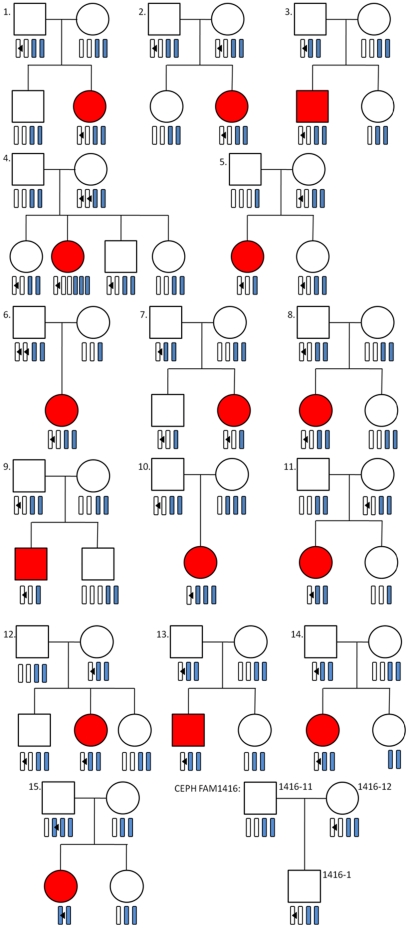
Mendelian inheritance pattern of the complement C4 exon 29 CT insertion.The genetic pedigrees illustrate 15 SLE families where the SLE proband harbours a CT insertion together with a single CEU trio where mother and son are known to harbour the CT insertion in C4A. Open squares identify healthy males, open circles identify healthy females, red squares indicate SLE affected males and red circles indicate SLE affected females. Open bars indicate C4A genes and blue bars indicate C4B genes. Black triangles identify the presence of the C4 exon 29 CT insertion.